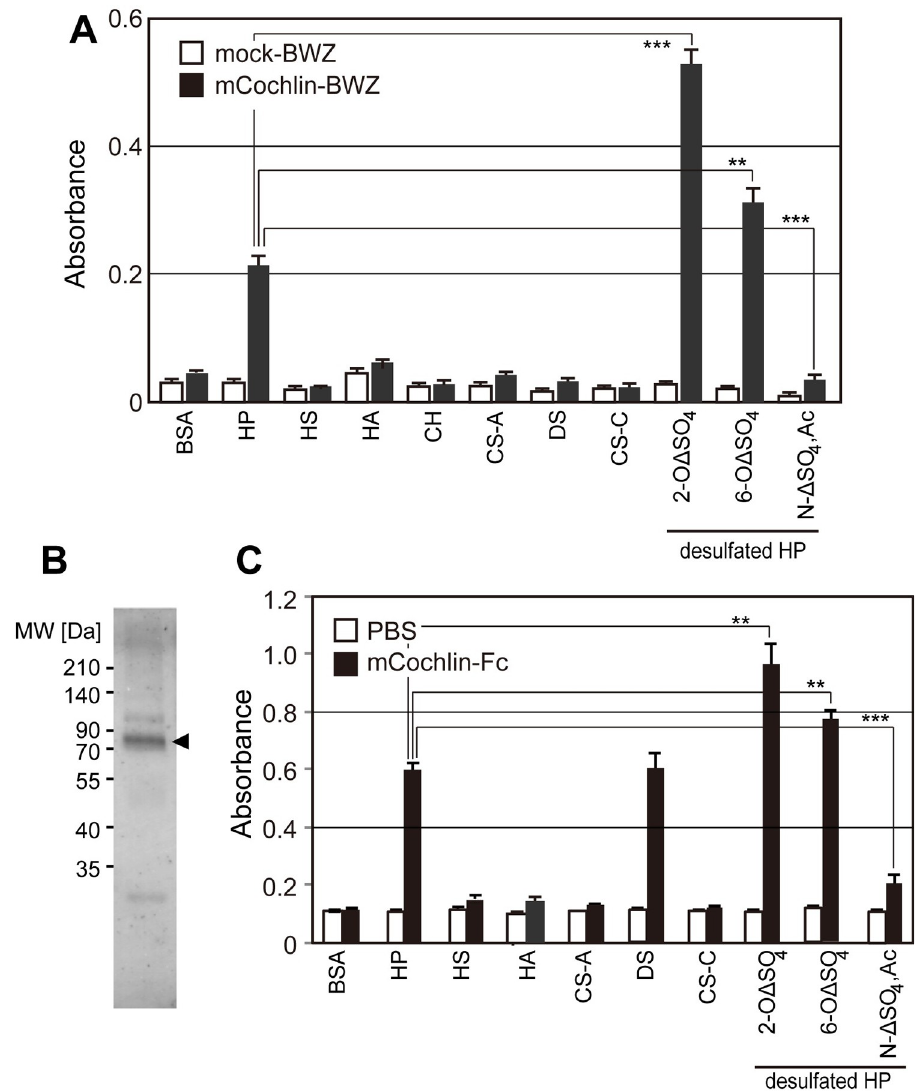
Fig 3. Binding of mouse cochlin to heparin and its desulfated derivatives. (A) Reporter assay of the interaction between mouse cochlin and several glycosaminoglycans. (B) Sodium dodecyl sulfate-polyacrylamide gel electrophoresis (SDS-PAGE) of purified mouse cochlin-Fc fusion protein (mcochlin-Fc). (C) Binding of mcochlin-Fc to immobilized GAG-BSA was analyzed by ELISA. ��� p < 0.005; �� p < 0.01 (Student’s t-test).